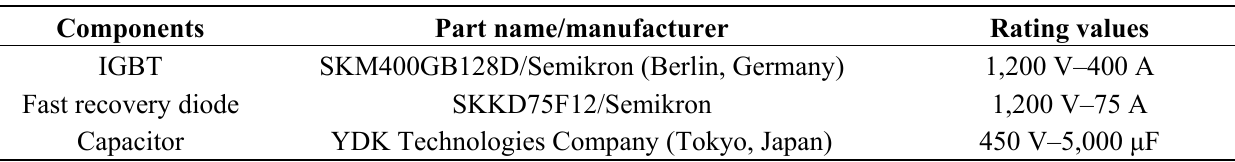
Table A1. Power transistor specifications adopted for the three-phase neutral point clamped (NPC)-VSC inverter. IGBT: insulated gate bipolar translator.